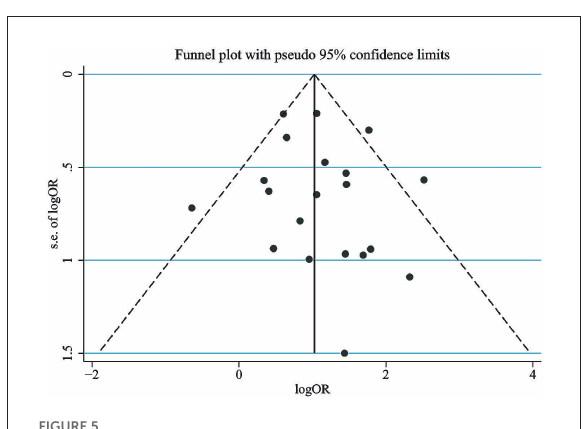
FIGURE5 Funnel plot of the included manuscripts, showing no significant publication